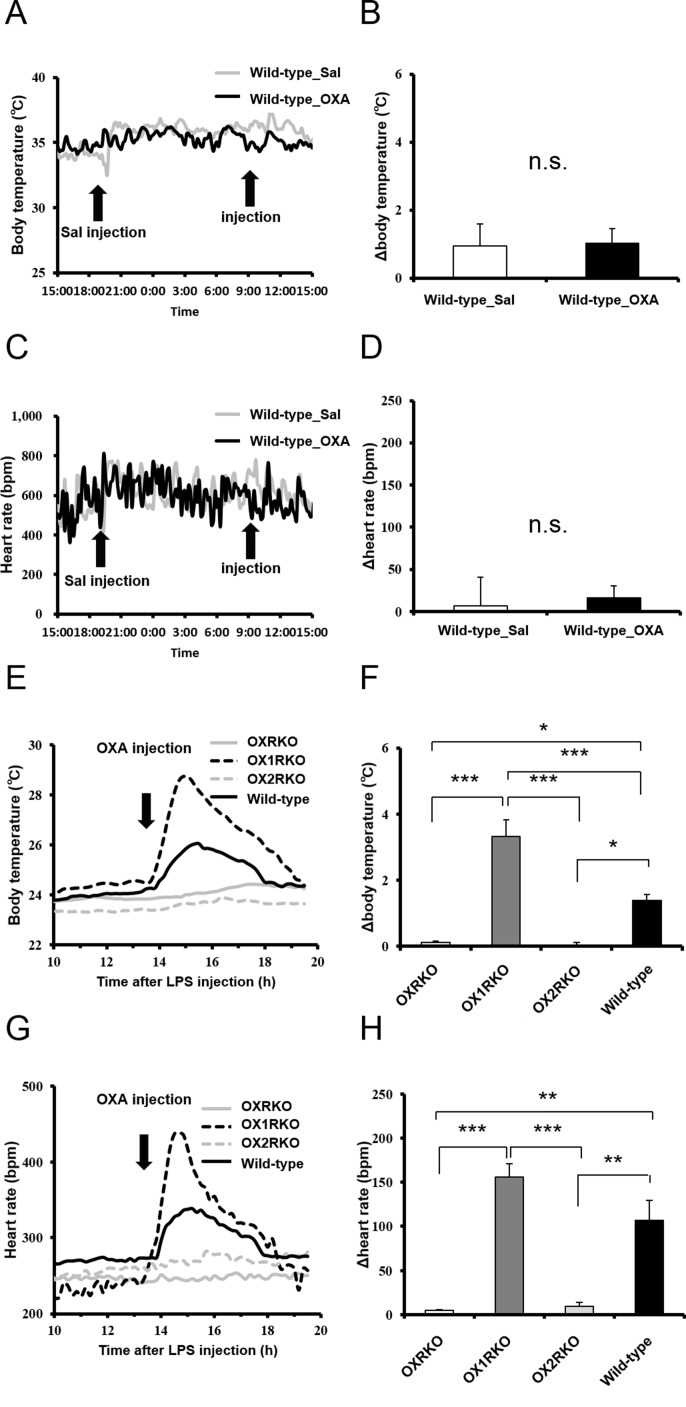
Transient effects of IP-injected OXA on body temperature and heart rate in healthy wild-type mice injected with saline (A, B, C, D) or in Hcrtr1-/-(OX1RKO) and Hcrtr2-/- (OX2RKO) mice with endotoxin shock (E, F, G, H).IP injection of OXA had no effects on body temperature and heart rate in healthy wild-type mice. In OX2RKO mice, transient effects of OXA on body temperature and heart rate in endotoxin shock were canceled. In OX1RKO mice, the transient effect of OXA on body temperature in endotoxin shock was significantly potentiated. (each group n = 4, *p<0.05, **p<0.01, ***p<0.001).